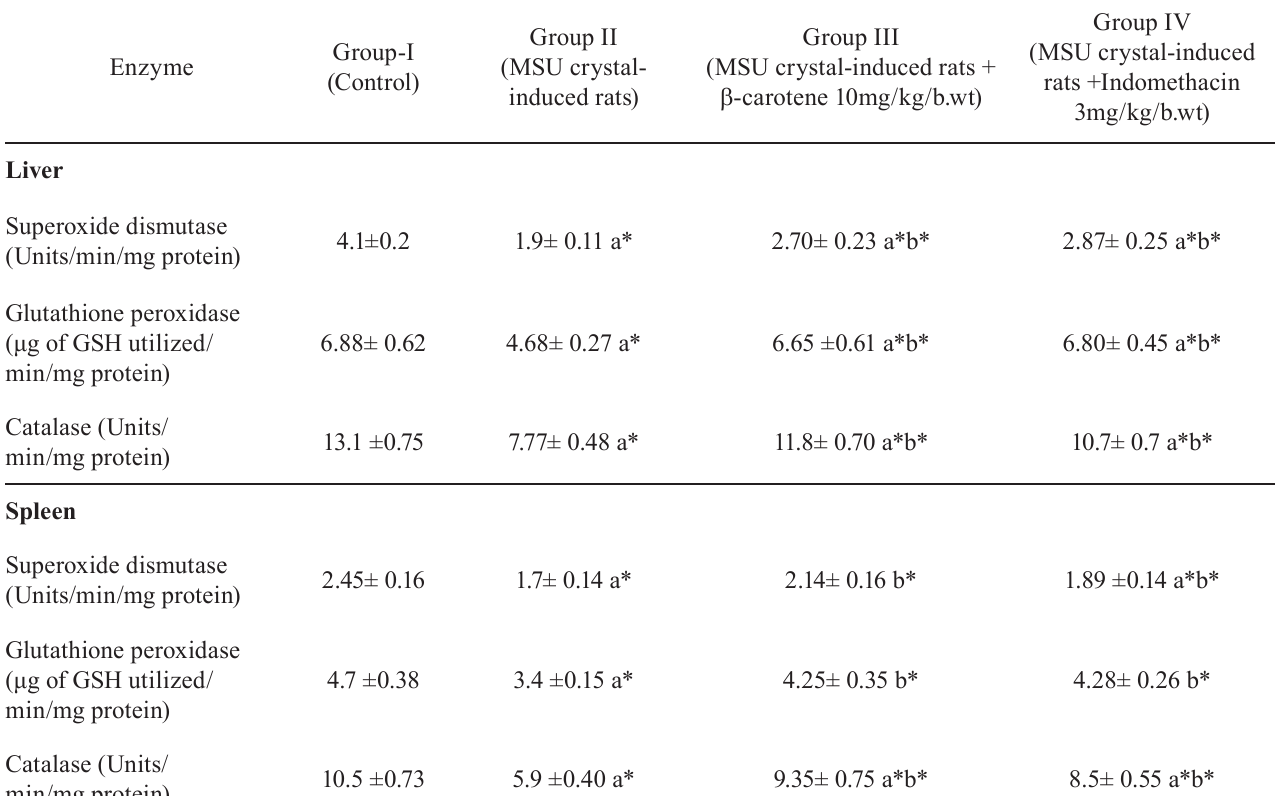
TABLE III - Effect of β -carotene and Indomethacin on antioxidants enzyme of liver and spleen of MSU crystal-induced arthritis rats